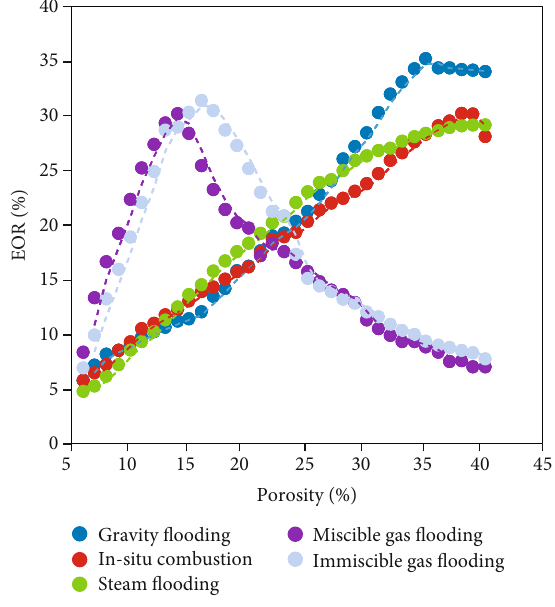
Figure 6: The e ff ect of porosity on EOR.